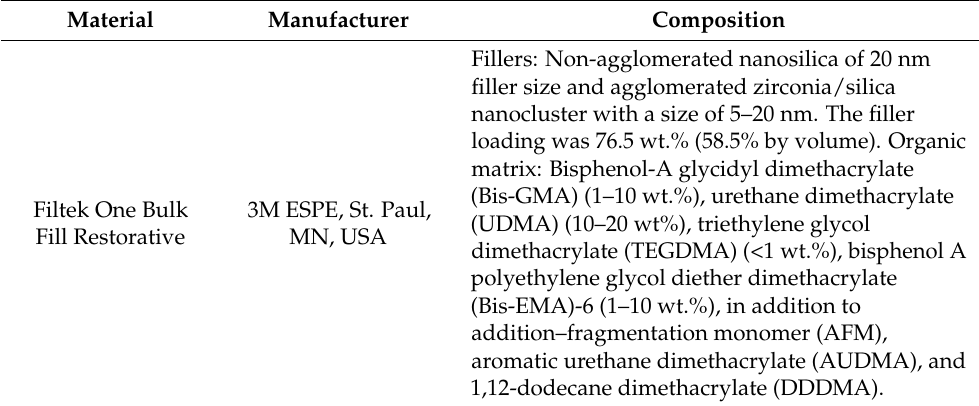
aromatic urethane dimethacrylate (AUDMA),